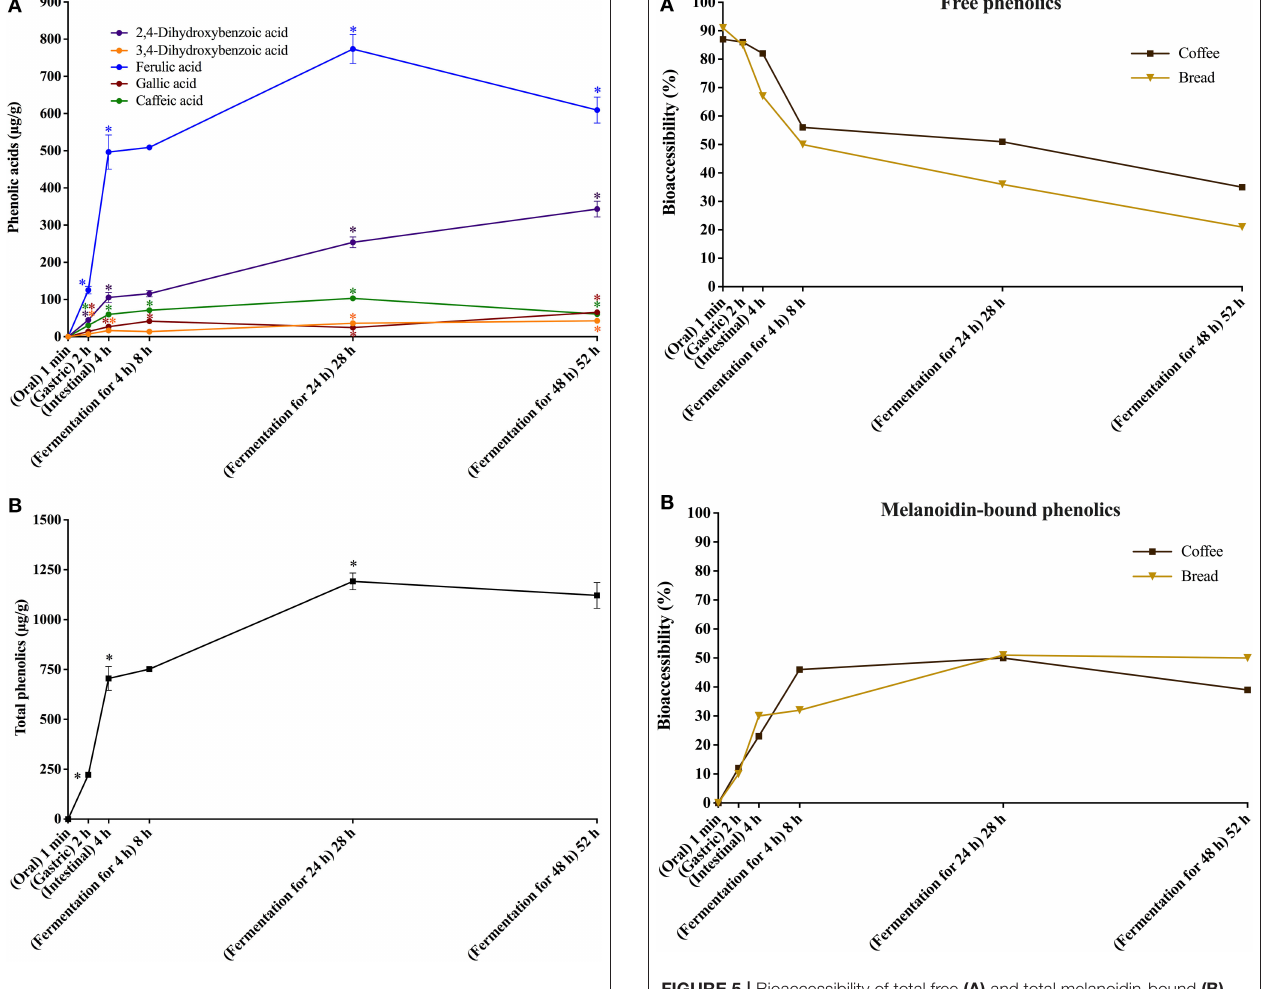
FIGURE 4 | In vitro simulated digestion (oral, gastric and intestinal steps) and gut fermentation of bread melanoidin-bound phenolic compounds: phenolic acids (A) and total phenolics (B) . The asterisk indicates a significant difference in relation to the previous step (ANOVA followed by Tukey’s post-test, p < 0.05).